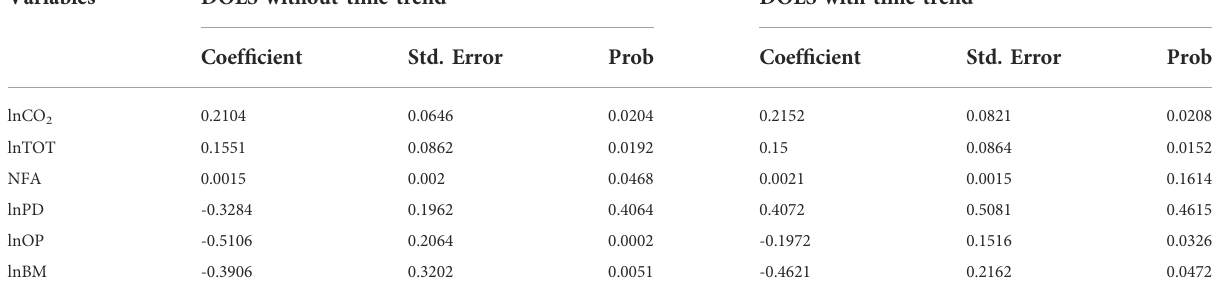
TABLE 4 Group-mean panel DOLS estimation results for the RER